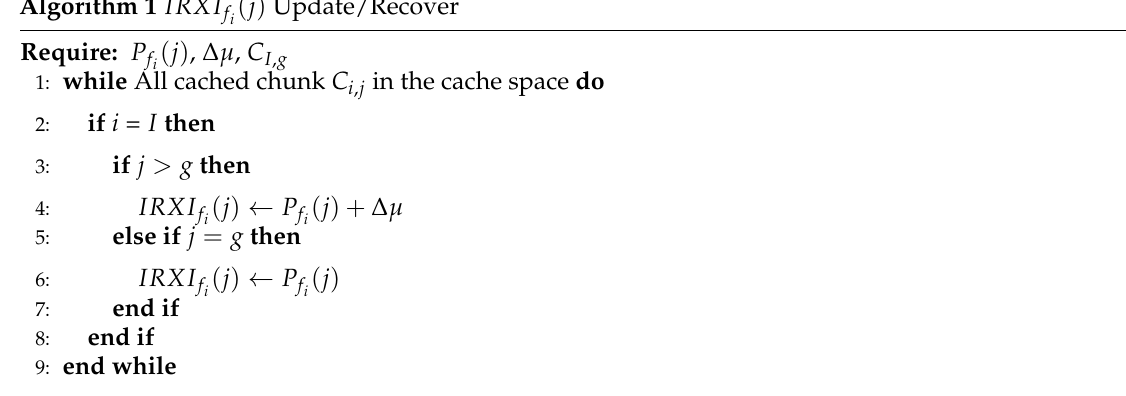
Figure 4. IRXI f